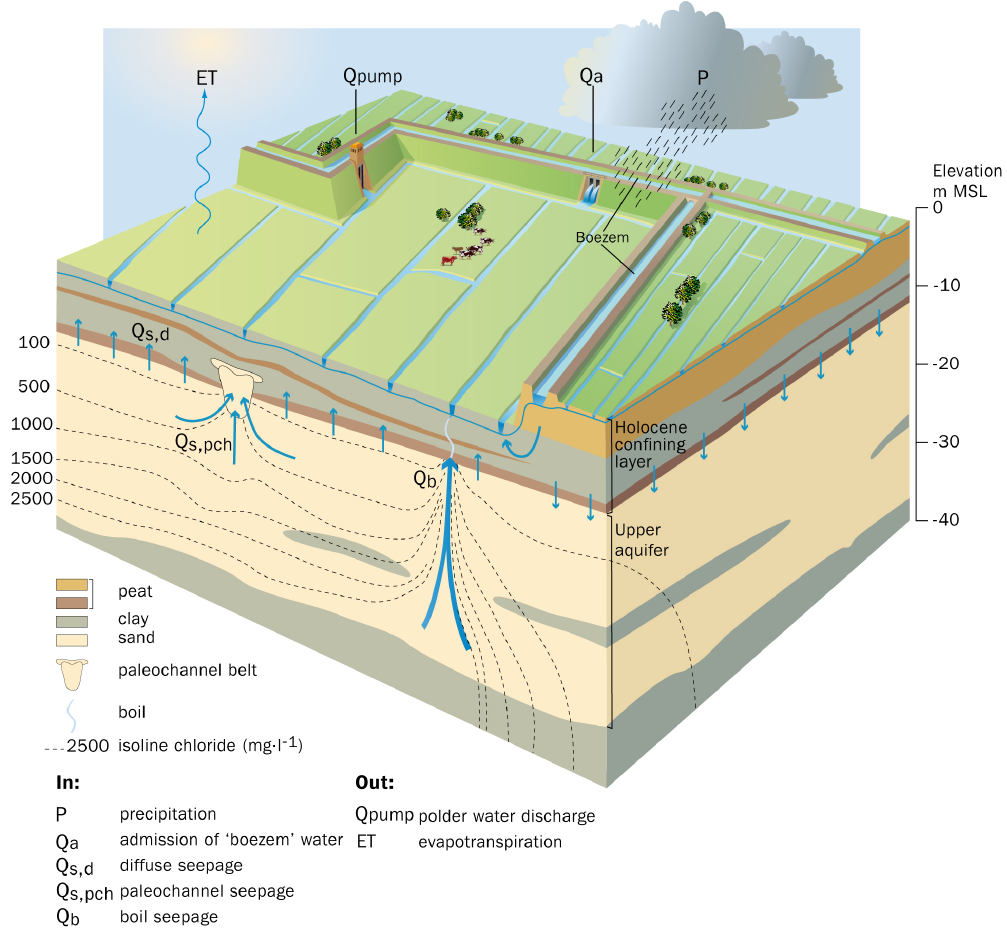
Fig. 1. The geohydrology and water and salt fluxes in a lowland polder catchment area. Upward groundwater seepage from the upper aquifer can be divided into three different types according to De Louw et al. (2010): diffuse-, paleochannel-, and boil